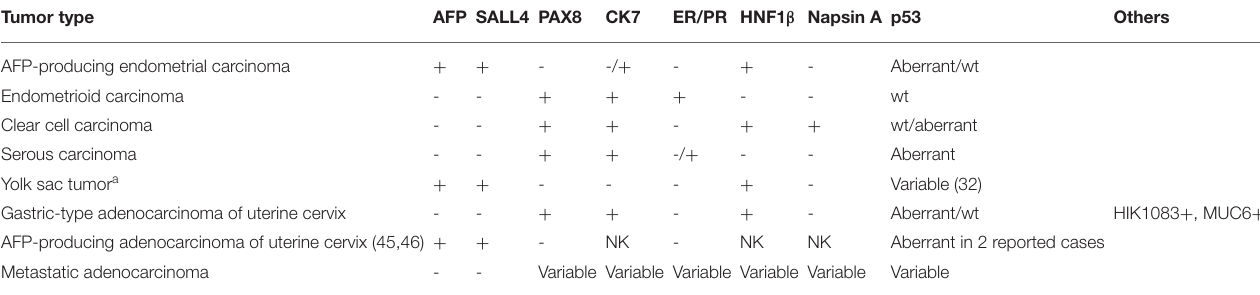
TABLE 5 | Immunohistochemical characteristics of AFP-producing endometrial carcinoma and other endometrial neoplasms in differential diagnosis. Tumor